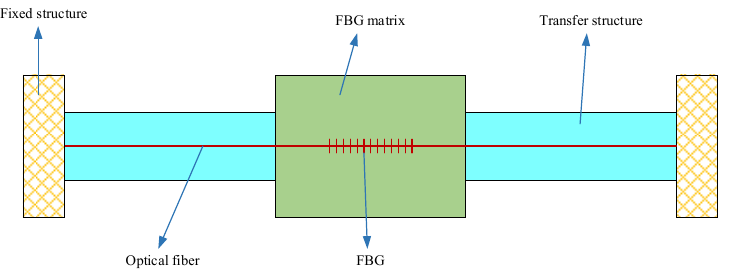
Figure 5. Schematic diagram of FBG strain desensitization sensor.